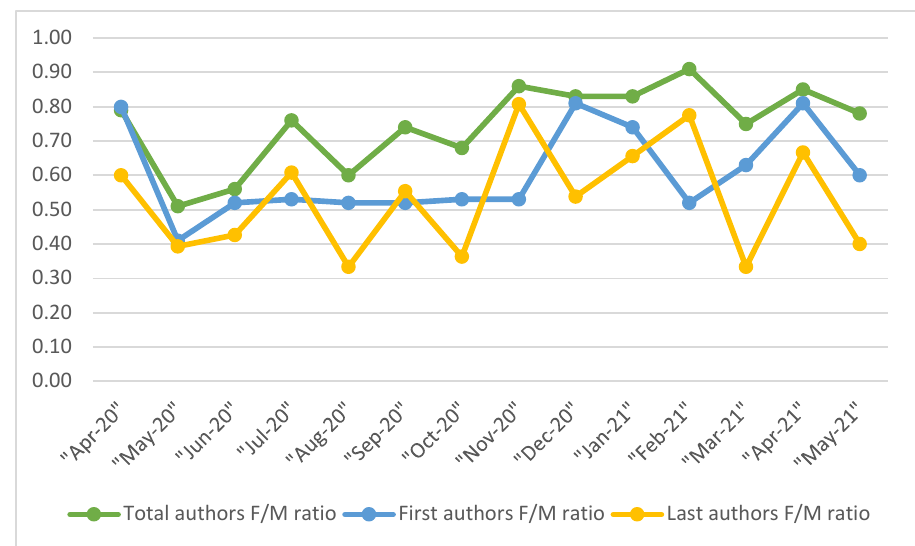
Figure 1. Evolution over time of the female/male (F/M) author ratio for total authors, first authors